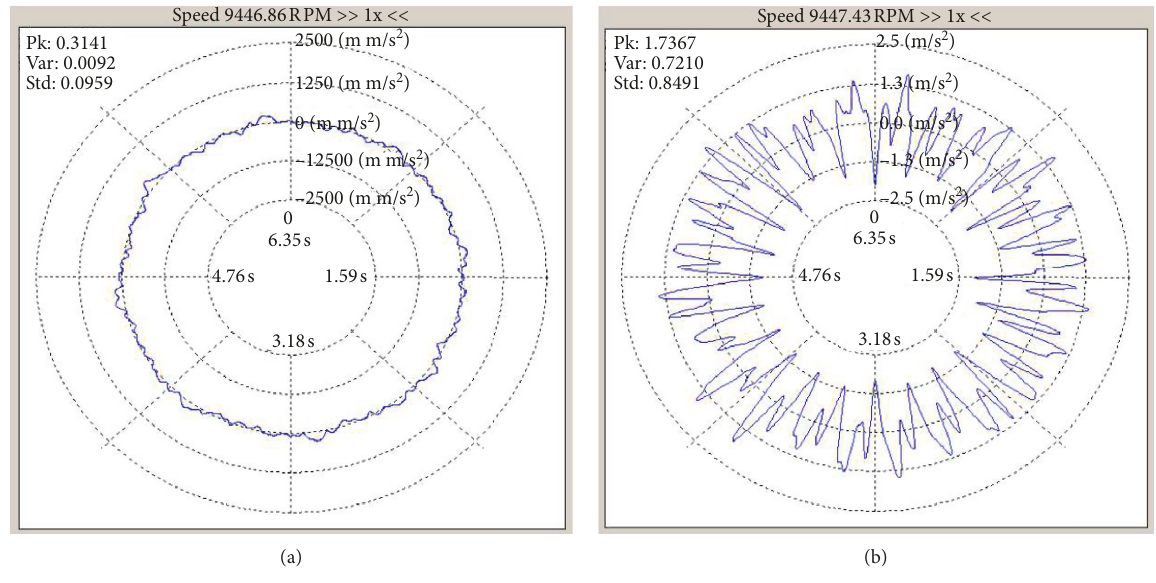
Figure 5: CTA analysis, quiet and unstable operation of the gear unit. Table 1: Assessment of kinematic viscosity and water content in lubricants.